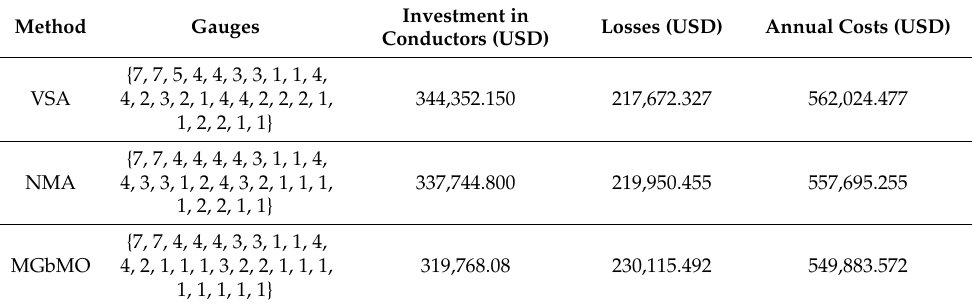
Table 11. Numerical results for the IEEE 27-bus system (balanced).